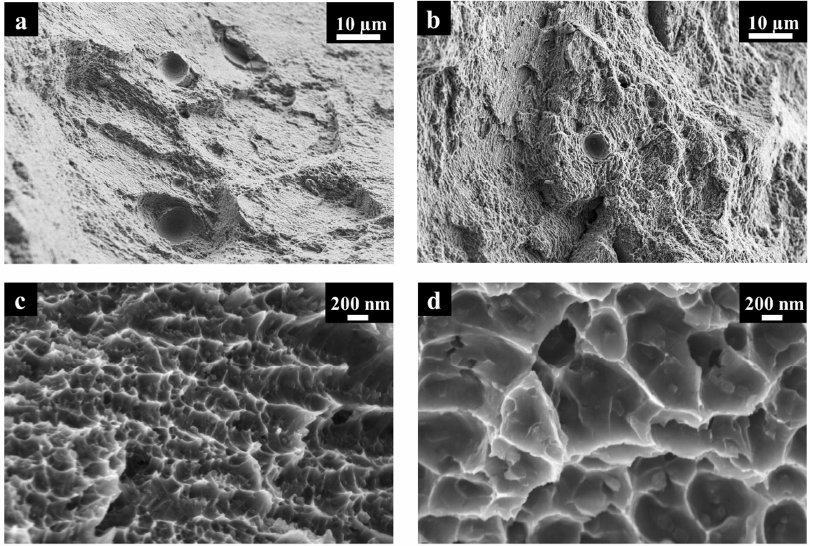
Figure 6. FESEM images of tensile fracture surface of LPBF samples built along x : ( a , c ) AlSi10Mg sample; ( b , d ) nanocomposite sample.